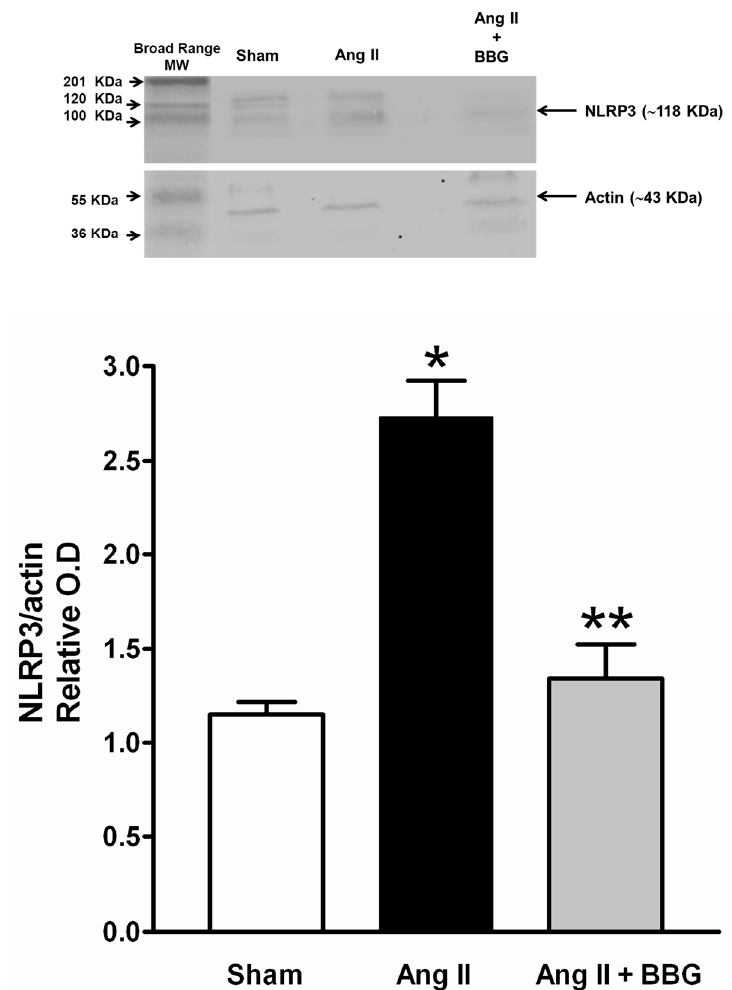
Figure 8. NLRP3 determined by WB in Sham, Ang II and Ang II + BBG. NLRP3 was increased with Ang II and significantly decreased with the administration of the antagonist. * p < 0.05 vs. Sham; ** p < 0.05 vs. Ang II. NLRP3 = (nucleotide-binding oligomerization domain (NOD), leucine-rich repeat (LRR)-containing protein 3) inflammasome; Ang II = angiotensin II; BBG = brilliant blue G.